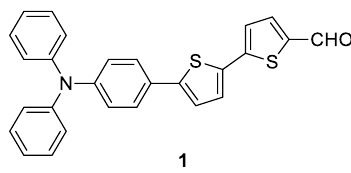
Figure 1. Structure of compound 1 .